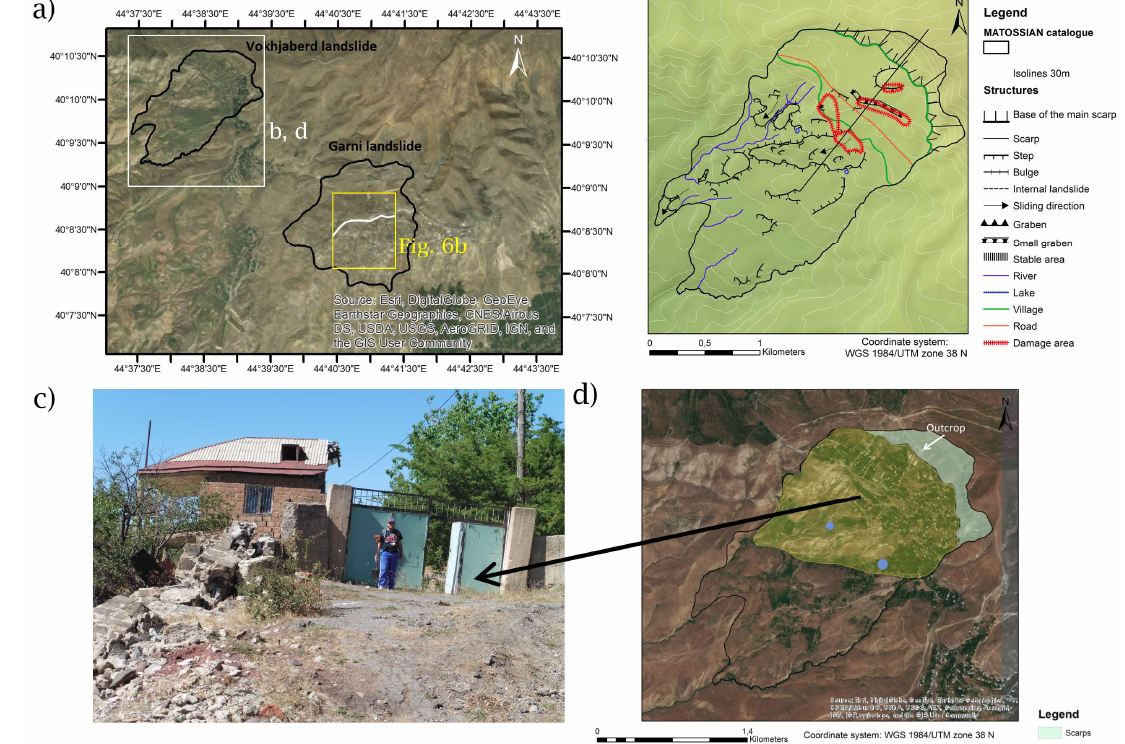
Figure 5. ( a ) The Vokhjaberd and Garni landslides, examples of ancient landslides of likely seismic origin near Yerevan. ( b ) Mapped morphological features of the Vokhjaberd landslide (scarp in the northeast and internal scarps in the central part, with damaged zones shown in red). ( c ) An example of a damaged house at the location indicated in ( d ). ( d ) Map showing the scarp zone in light blue-green and the active part of the landslide in green-yellow.